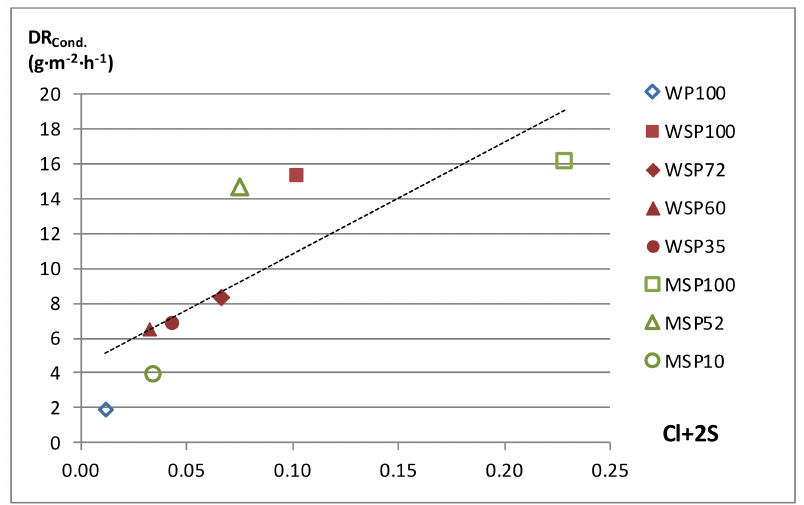
Figure 8. Deposition rate by condensation versus Cl + 2S (mol/kg fuel